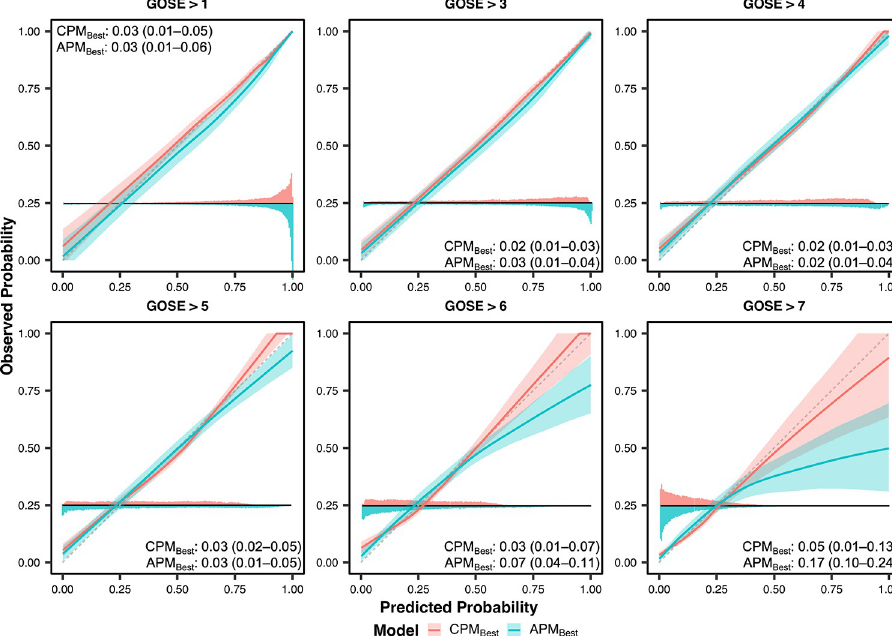
Fig 3. Ordinal calibration curves of best-performing concise-predictor-based model (CPM Best ) and best- performing all-predictor-based model (APM Best ). GOSE = Glasgow Outcome Scale–Extended at 6 months post- injury. In each panel, a comparative histogram (200 uniform bins), centred at a horizontal line in the bottom quarter, displays the distribution of predicted probabilities for CPM Best (above the line) and APM Best (below the line) at the given GOSE threshold. CPM Best and APM Best correspond to the CPM ( S2 Table ) and APM ( S3 Table ), respectively, with the lowest unweighted average of integrated calibration indices (ICI) across the thresholds. Shaded areas are 95% confidence intervals derived using bias-corrected bootstrapping (1,000 resamples) to represent the variation across repeated k -fold cross-validation folds (20 repeats of 5 folds) and, for CPM Best , 100 missing value imputations. The values in each panel correspond to the mean ICI (95% confidence interval) at the given threshold. The diagonal dashed line represents the line of perfect calibration (ICI =